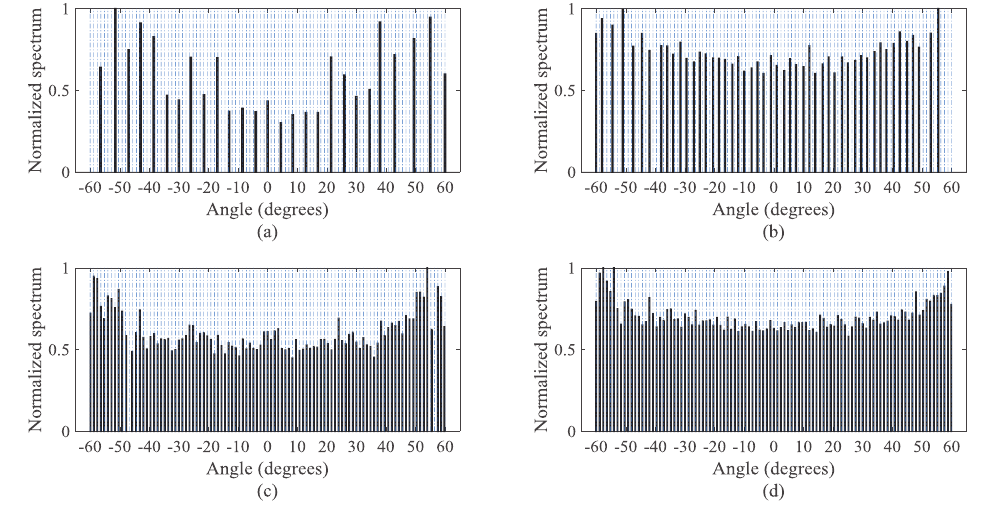
Figure 7. Spatial spectra of the uniformly distributed signals detected by the four virtual configurations ( Q = 101 and SNR = 10 dB): ( a ) the ULA with the NC MUSIC used; ( b ) the ULA with the VNCM used; ( c ) the CAMpS with the VNCM used; and ( d ) the DsCAMpS with the VNCM